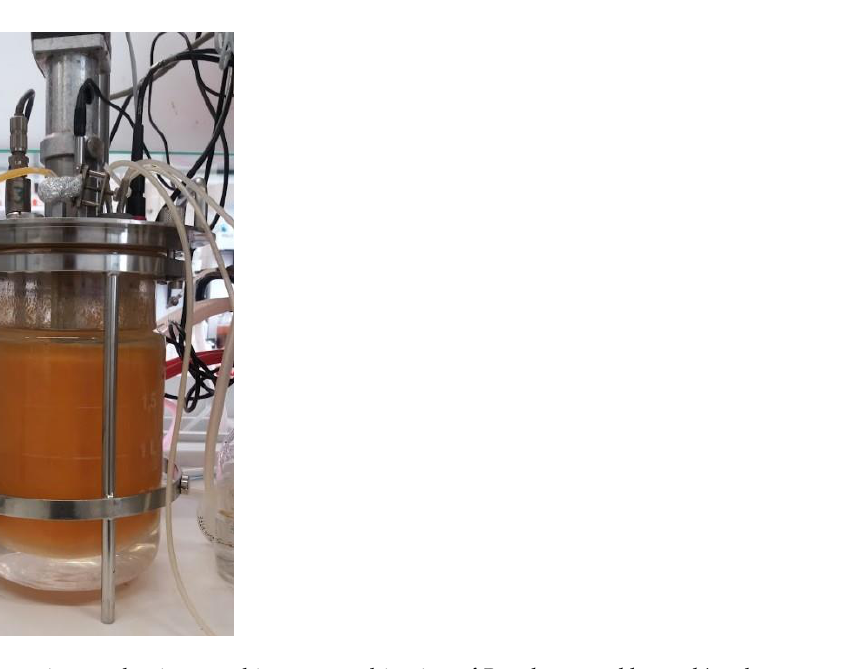
Figure 1. On agar plate, strains : P. chlororaphis 30-84 wildtype (WT), phenazine non-producer (ZN), PCA only producer (PCA), and 2-OH-PCA overproducer (O*) [18].